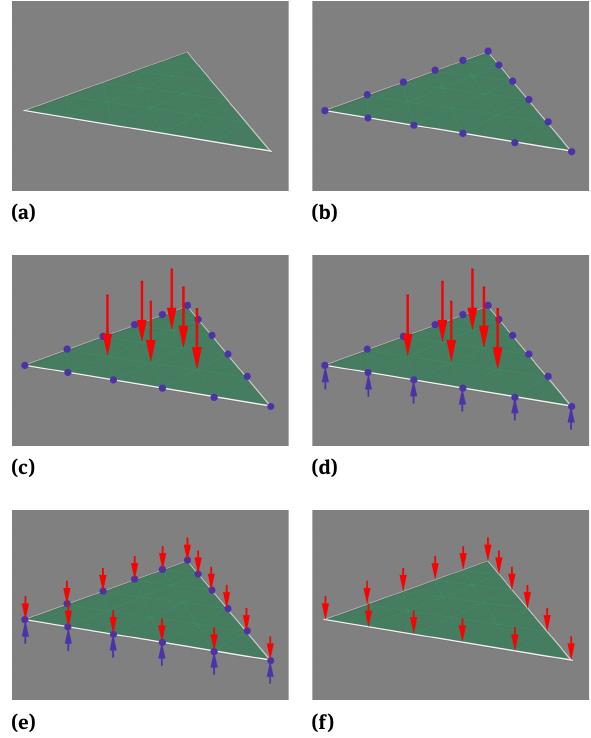
Figure 13: a) Schematic view of a single field of the dome: the green mesh is a membrane envelope and white tubes are the poles, b) Blue points which are mesh vertices on the poles, observed as support points for the membrane mesh, c) Load applied on the membrane mesh with shown support points, d) Resistant forces at the support points, e) Equilibrium of the forces at the support points, f) Forces obtained from the equilibrium state for the support points that load the